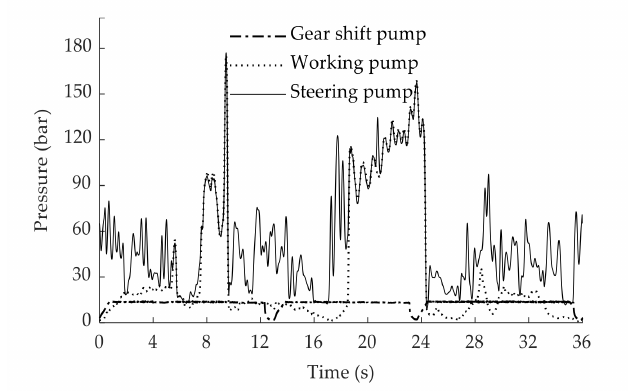
Figure 9. Pressure of pumps in a duty